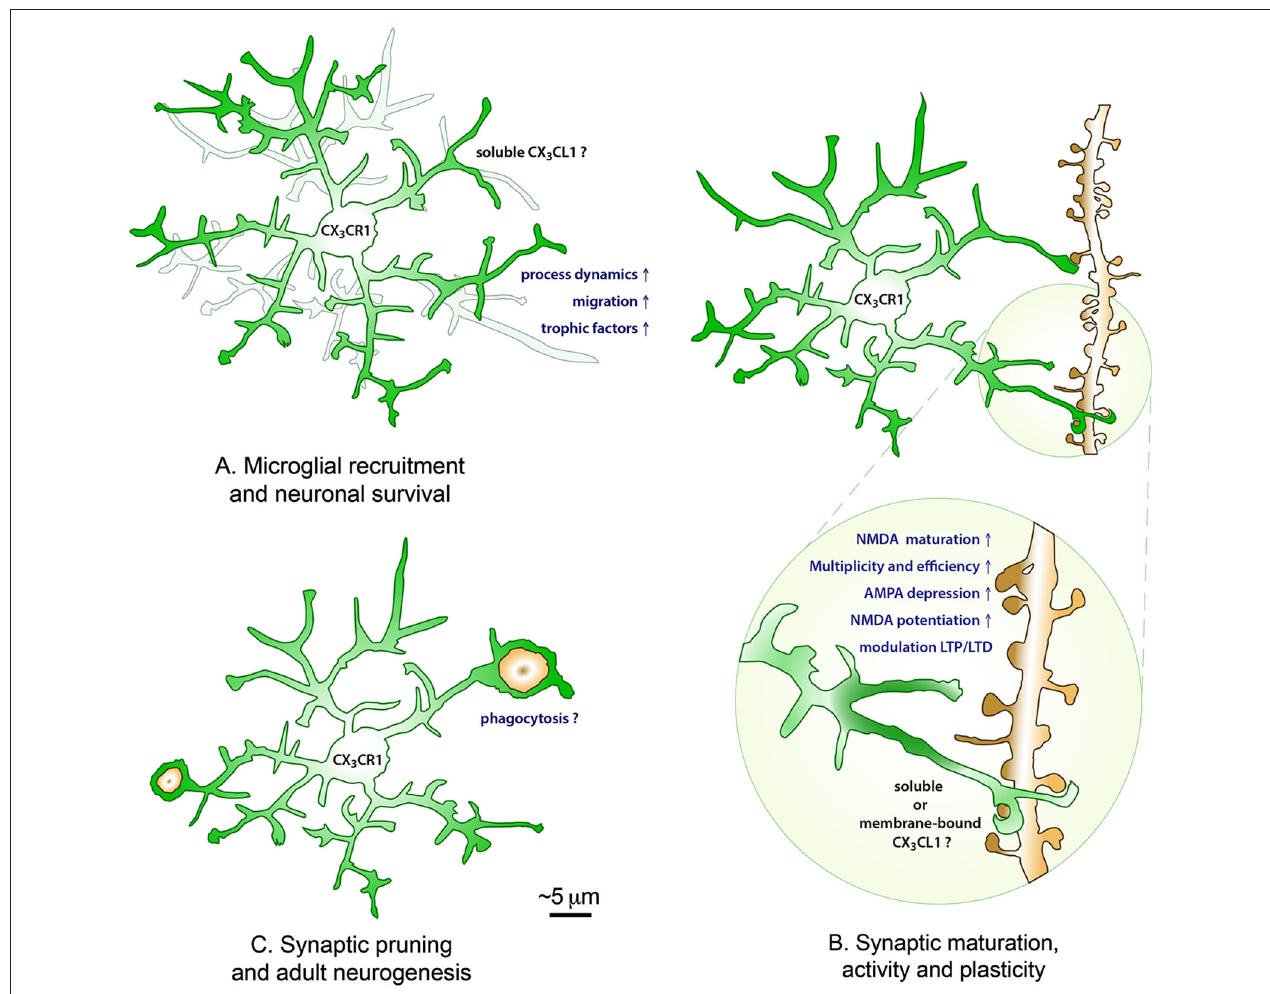
transmission, the depression of AMPA receptors and potentiation of NMDA receptors, and the modulation of LTP and LTD at the Schaffer collateral synapse in the hippocampus CA1 (B) , with lasting consequences on the brain functional connectivity, learning and memory, and the behavioral outcome. Additionally, fractalkine signaling might be influencing the developmental pruning of synapses and adult hippocampal neurogenesis by regulating microglial phagocytosis of synaptic elements and newborn apoptotic cells during normal physiological conditions (C)